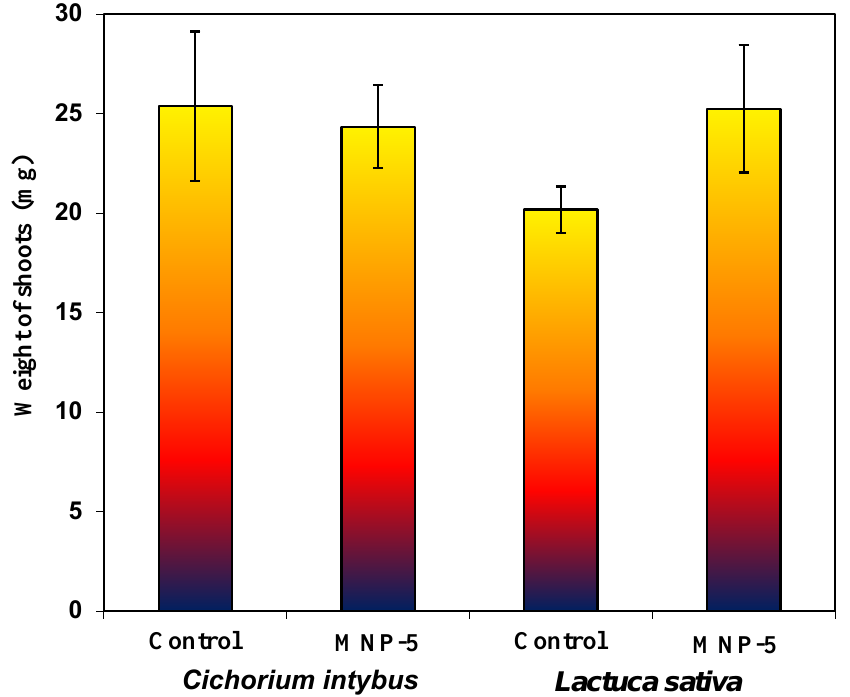
Figure 13. The effect of MNPs on the shoot weight of Cichorium intybus L. and Lactuca sativa L. (control plants and pretreated with the MNP-5 sample).